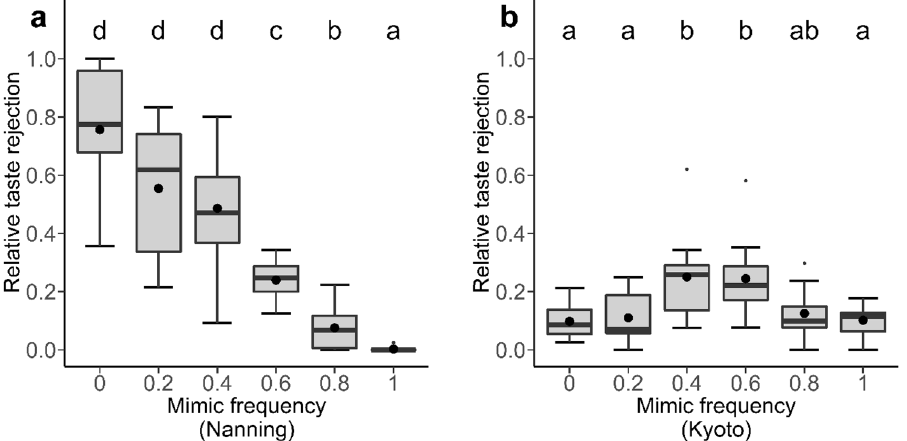
Figure 3. The proportion of attacked prey that were taste rejected by birds at different mimic frequencies in Nanning ( a ) and in Kyoto ( b ). The letters indicate commonalities among groups. Black dots represent mean values of each column. Each box represents 10 data